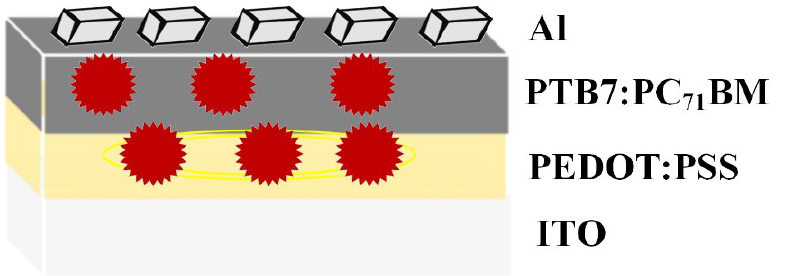
Figure 2. Device architecture of BHJ PSCs with embedded Au@Ag NPs in two different layers.